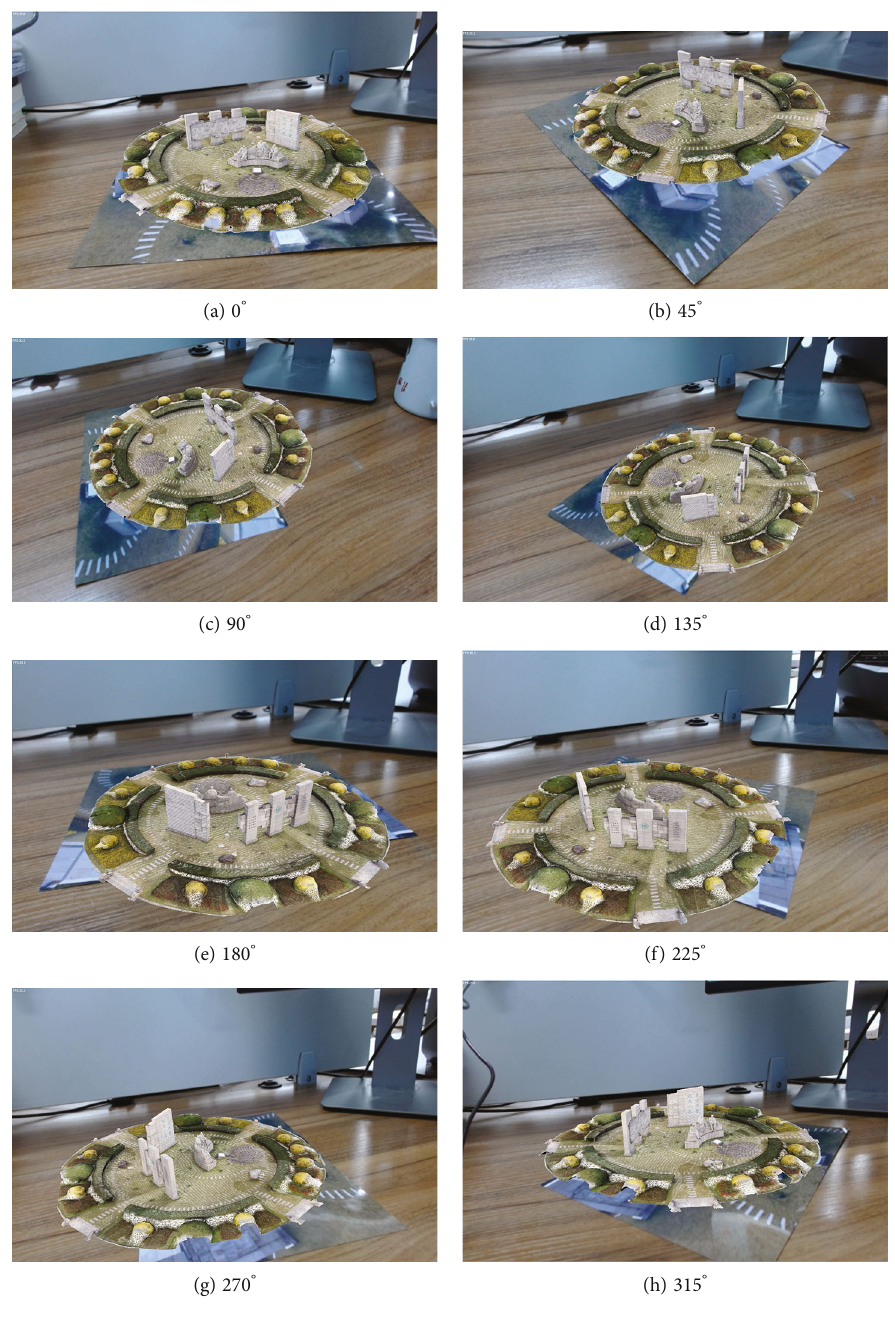
Figure 8: Fusion e ff